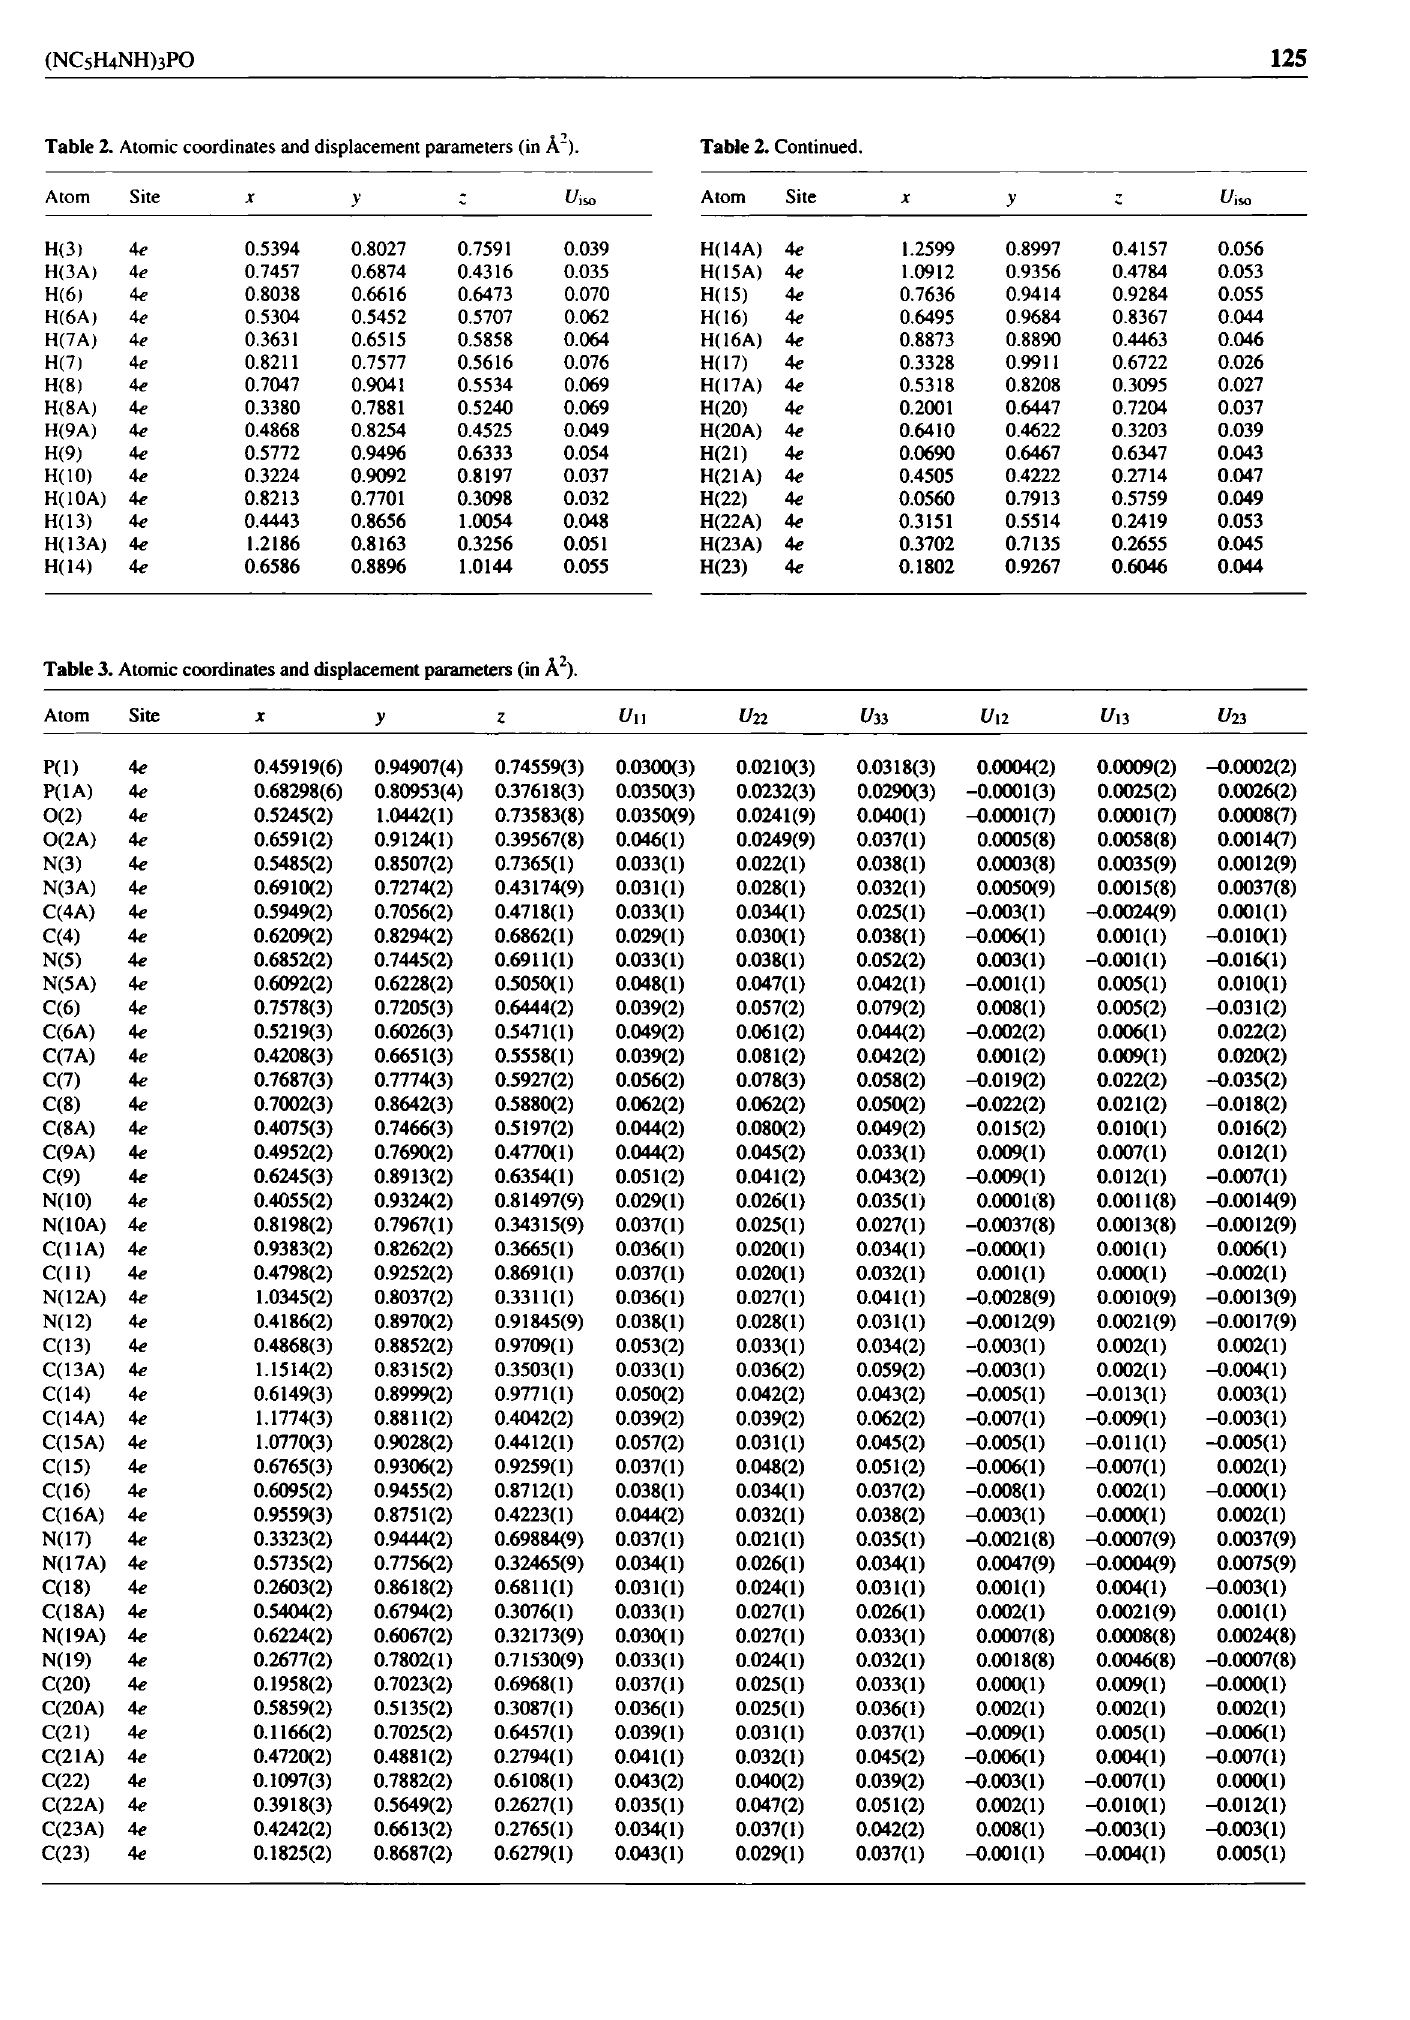
Table 2. Atomic coordinates and displacement parameters (in Ä 2 ).